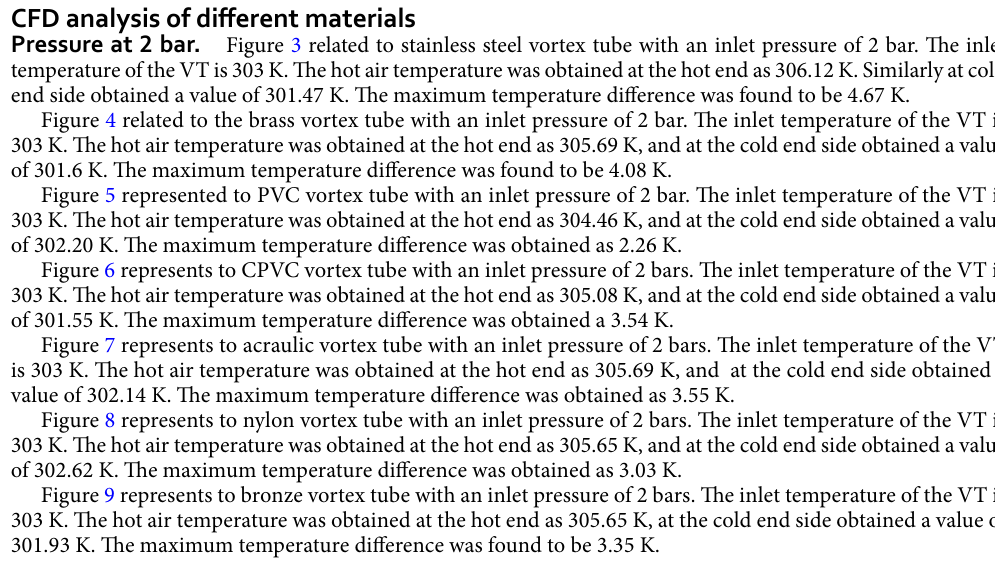
Figure 7 represents to acraulic vortex tube with an inlet pressure of 2 bars. The inlet temperature of the VT is 303 K. The hot air temperature was obtained at the hot end as 305.69 K, and at the cold end side obtained a value of 302.14 K. The maximum temperature difference was obtained as 3.55 K. Figure 8 represents to nylon vortex tube with an inlet pressure of 2 bars. The inlet temperature of the VT is 303 K. The hot air temperature was obtained at the hot end as 305.65 K, and at the cold end side obtained a value of 302.62 K. The maximum temperature difference was obtained as 3.03 K. Figure 9 represents to bronze vortex tube with an inlet pressure of 2 bars. The inlet temperature of the VT is 303 K. The hot air temperature was obtained at the hot end as 305.65 K, at the cold end side obtained a value of 301.93 K. The maximum temperature difference was found to be 3.35